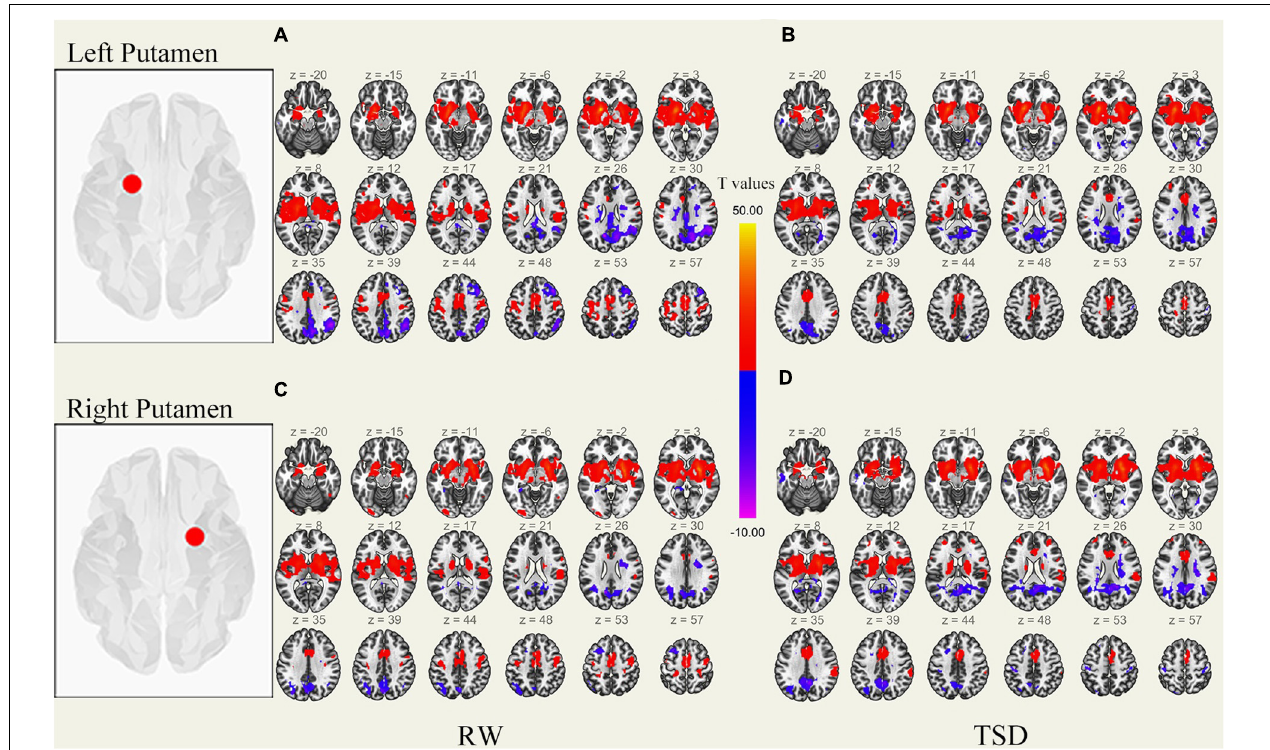
FIGURE 1 | Whole-brain functional connectivity patterns of the putamen before 36 h TSD shown at panels (A,C) , and after 36 h TSD shown at panels (B,D) ( n = 30) (Transverse view). Warm colors indicate positive correlations, and cold colors indicate negative correlations.